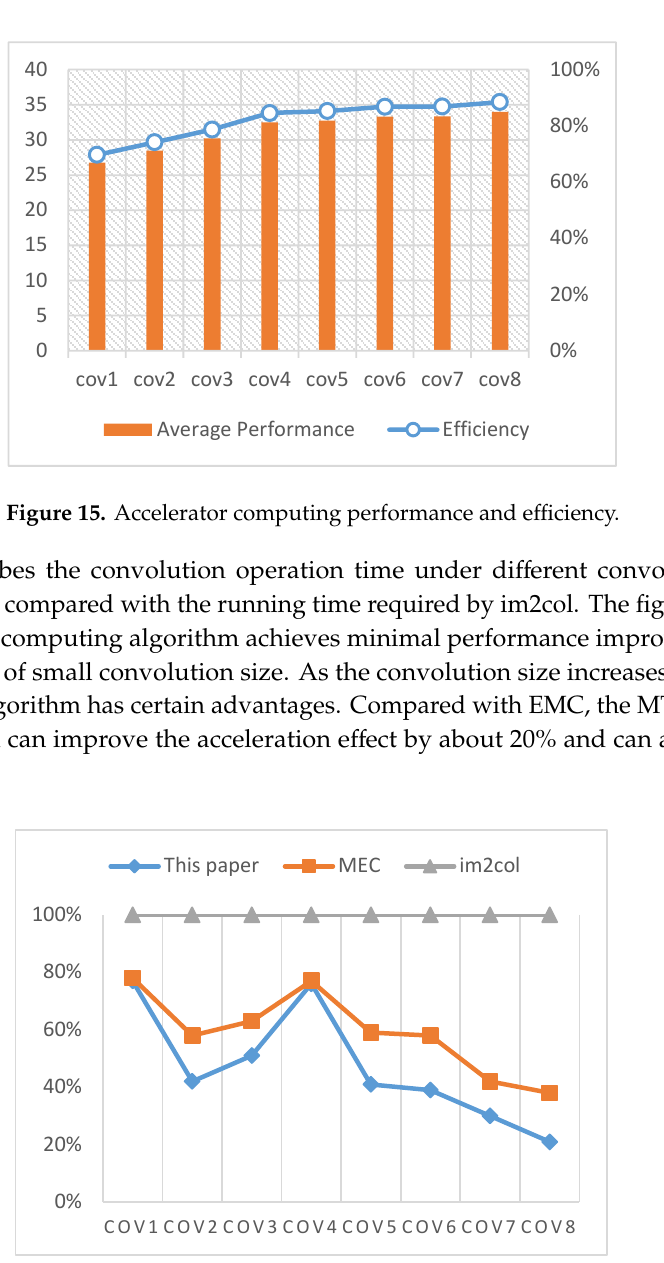
Figure 17. Per unit power operation Performance of different processors handling cov8.